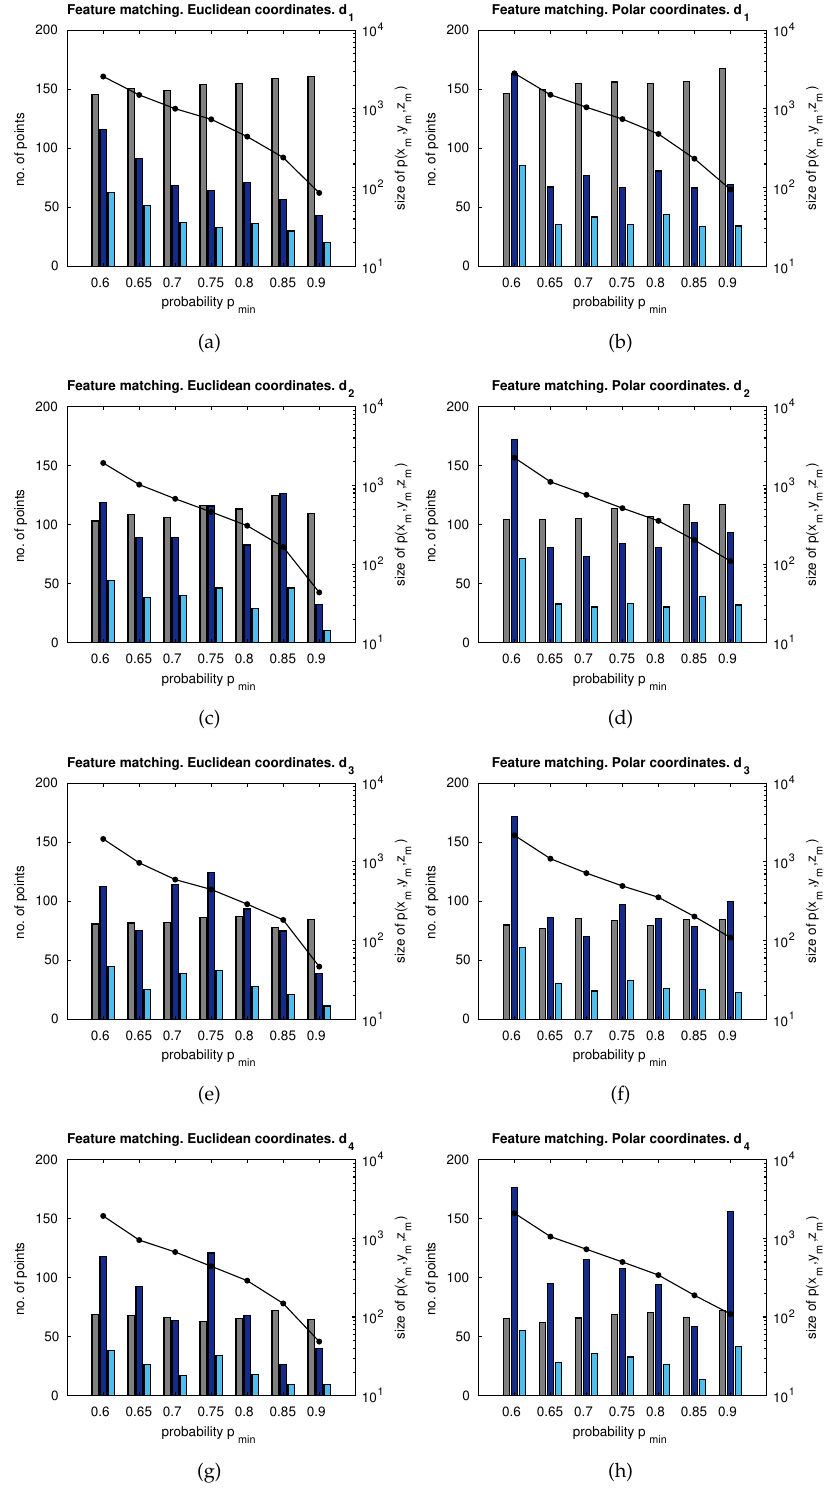
Figure 11. Left axes: number of matches versus p min . Right axes: size of the probability distribution ( log ) versus p min . −•− size[ p ( x m , y m , z m ) ]. Euclidean coordinates and distance between capture points: ( a ) d 1 ; ( c ) d 2 ; ( e ) d 3 ; ( g ) d 4 . Polar coordinates and distance between capture points: ( b ) d 1 ; ( d ) d 2 ; ( f ) d 3 ; ( h ) d 4 . Legend: (cid:4) Standard matching; (cid:4) proposed matching candidates; (cid:4) proposed final